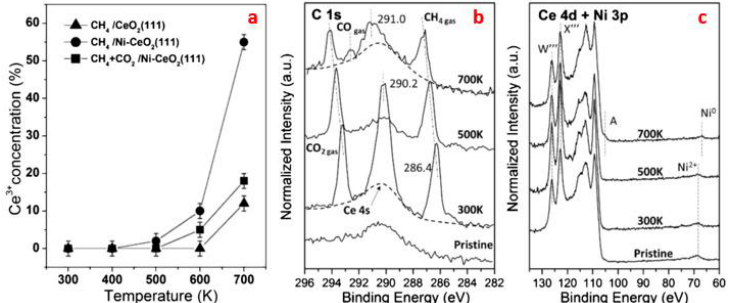
Figure 7. ( a ) Ce 3+ concentration measured in XPS as a function of temperature under reaction conditions (i.e., exposure to 100 mTorr of methane or a mixture of 100 mTorr of methane and 100 mTorr of CO 2 ). ( b , c ) C 1s and Ce 4d + Ni 3p spectra of the Ni-CeO 2 (111) (θ Ni ≈ 0.1 ML) surface under 100 mTorr CH 4 + 100 mTorr of CO 2 at 27, 227, and 427 °C. Reproduced with permission from reference [65]. Similarly, in another work, under a small Ni coverage, Ni and O atoms collaboratively activated the C-H bond in CH 4 , leading to a good conversion at low reaction temperature 377 °C. Due to the strong MSI and electrons transfer from Ni to CeO 2 , Ni 2+ and Ce 3+ formed, generating the most stable site Ni 2+ @O-hollow. Ni 2+ was the only Ni species either before or after the adsorption of CH 4 at room temperatures. When the coverage of Ni increased to 0.5 ML, NiC x species appeared on the surface; when the Ni coverage was below 0.2 ML, the small Ni atoms or particles contacted closely with the CeO 2 support, resulting in a much lower activation energy of CH 4 than that with a Ni coverage of 0.5 ML. A small loading of Ni formed small particles, which experienced large electronic perturbations from CeO 2 . These small Ni particles and O atoms in CeO 2 promoted the activation of CH 4 in a cooperative way. When Ni 2+ /CeO 2 was transformed to Ni 0 /CeO 2-x by reacting with C species from CH 4 decomposition, CO and oxygen vacancies were generated [67,140,141]; the oxygen vacancies formed on the reduced CeO 2-x facilitated the adsorption and activation of CO 2 , thus leading to an